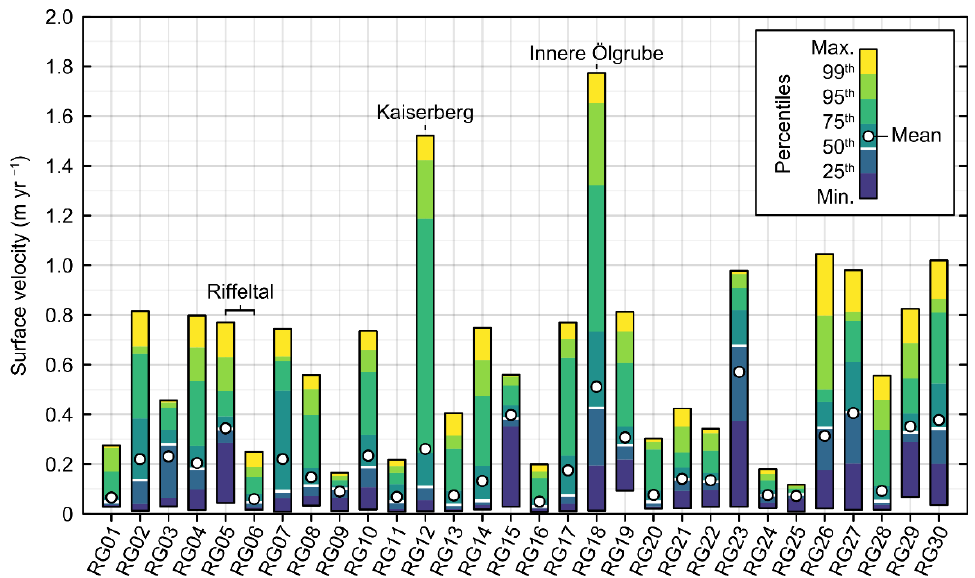
Figure 3. Horizontal surface velocities of 30 active rock glaciers, averaged over the entire observation period (2001 resp. 2003 to 2015). Values are shown as percentiles to illustrate the heterogeneity of rock glacier velocity fields (see Figure 1 for the location of rock glaciers).